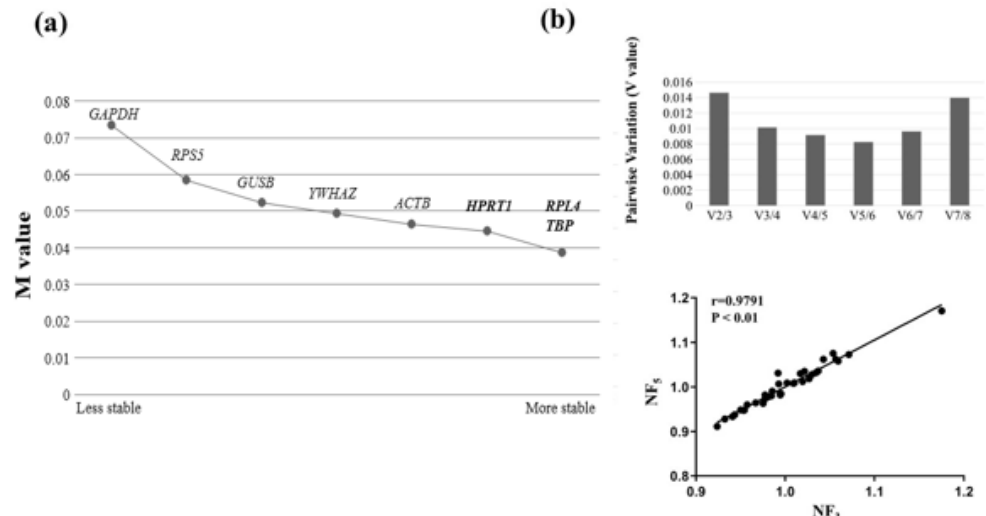
Figure 3. Assessment for the stability of reference gene used geNorm. ( a ) The graph presents the ranking of stability of the reference gene. The right side of the graph represents the most stable reference gene, and the left side of the graph represents the most unstable reference gene. The best of three stable reference genes was shown in bold letters. ( b ) The graph shows the optimal number of reference gene at normalization (NFopt). NFopt was present 5 reference gene (NF5) by pairwise variation (V5/6). Between NF3 and NF5, Pearson’s correlations of normalization factor analyzed by SPSS was suggest high correlation (r = 0.9791, p < 0.01).